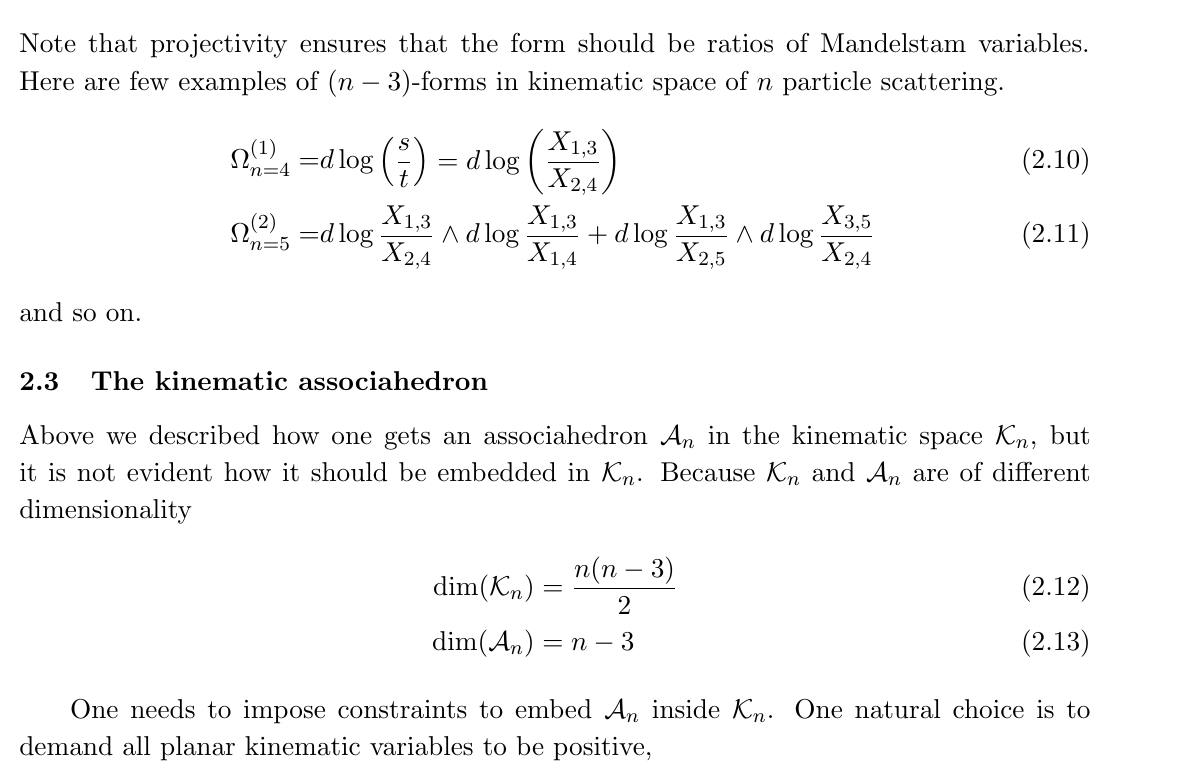
i,j → X i (cid:31) ,j (cid:31)